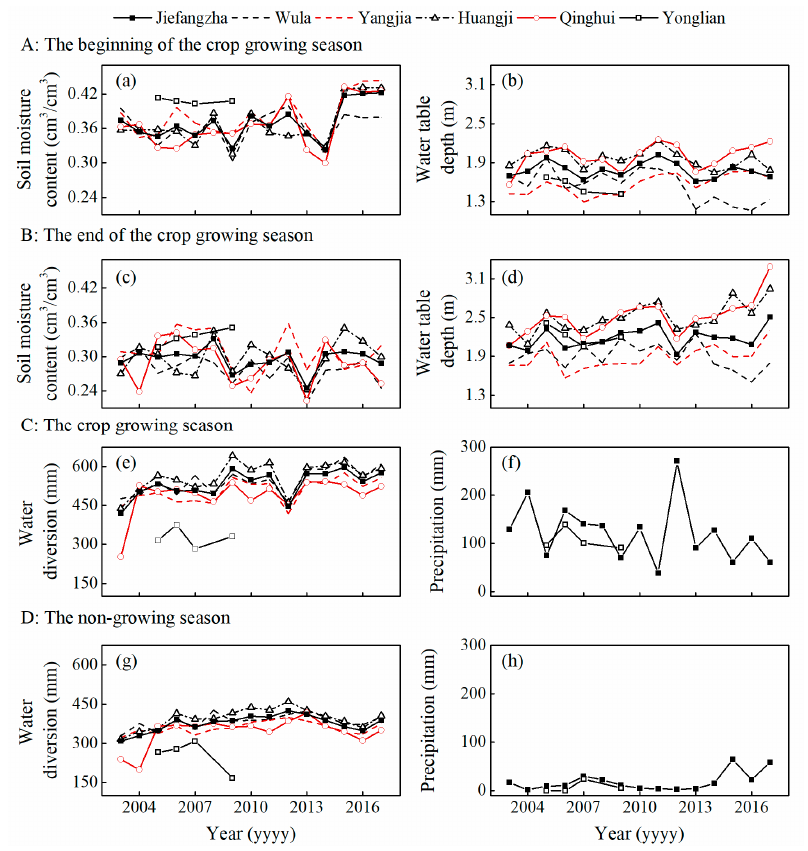
Figure 2. The measurements in Jiefangzha and its four subareas, and Yonglian. Measurements of ( a ) soil moisture content within 1 m soil depth and ( b ) water table depth at the beginning of the crop growing season. Measurements of ( c ) soil moisture content within 1 m soil depth and ( d ) water table depth at the end of the crop growing season. ( e ) The water diversion and ( f ) precipitation during the crop growing season. ( g ) The water diversion (autumn irrigation) and ( h ) precipitation during the non-growing